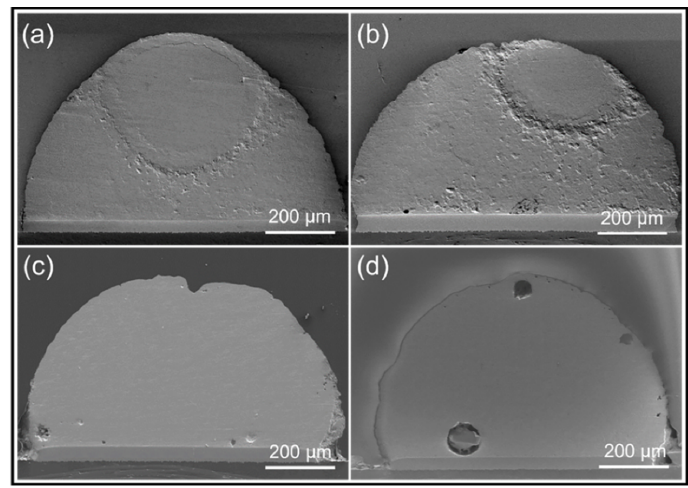
Figure 4. Overall SEM images of 13.5Sn-37.5Bi-45In-4Pb solder paste and SAC305 solder ball after reflowing at ( a ) 100 °C, ( b ) 120 °C, ( c ) 140 °C and ( d ) 160 °C for 5 min, respectively. Higher magnification SEM images in Figure 5 show the uniformity of the microstruc- ture after reflowing at 140 °C for 5 min. Figure 5a–f are the 500× magnification SEM images of the lower left, left, upper-left edge, upper right-edge, right, and lower right parts of the solder joint, respectively, and (g–i) are the 2000× enlarged view of the connection between the solder joint and the Cu plate, the middle and top of the solder joint. According to Figure 5, the composition of the mixed solder obtained after reflowing at 140 °C for 5 min is completely homogeneous. Therefore, 140 °C is considered the optimum temperature to obtain a fully mixed solder of 13.5Sn-37.5Bi-45In-4Pb and SAC305.